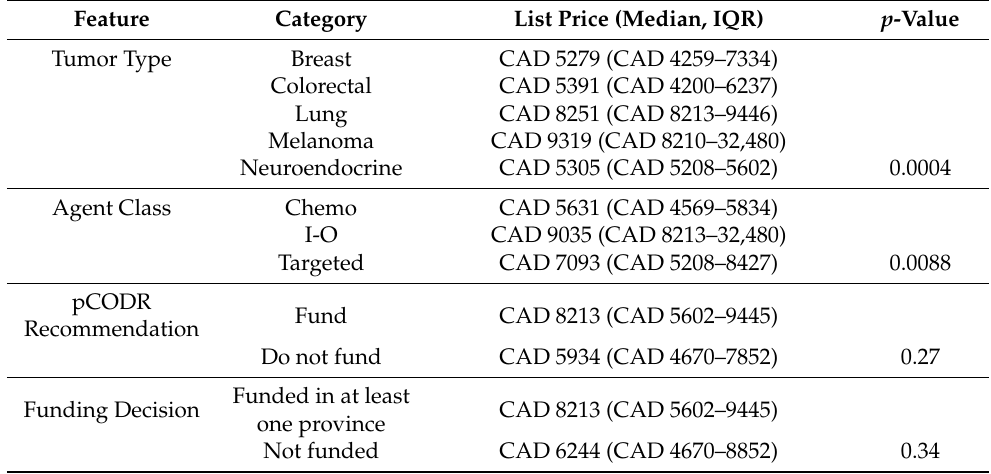
Table 4. Association of drug features and list